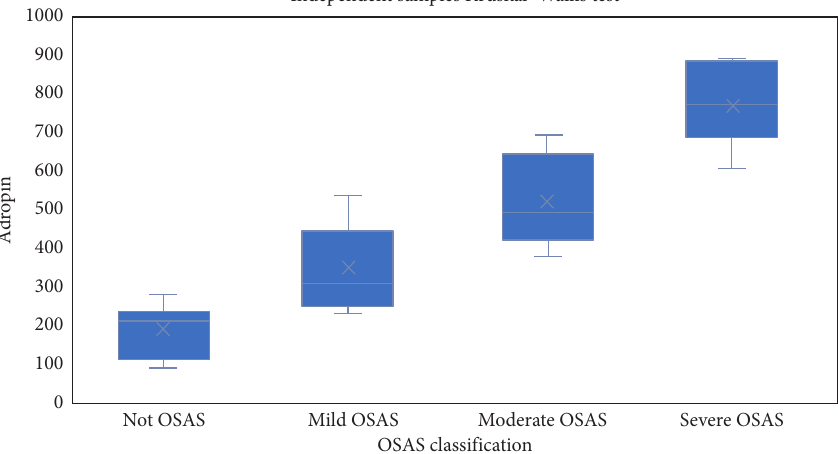
Figure 2: Distribution of adropin values according to OSAS classes. Table 3: Kruskal–Wallis H test results carried out for determining the difference between the OSAS classes and IL-1 beta and TNF- alpha